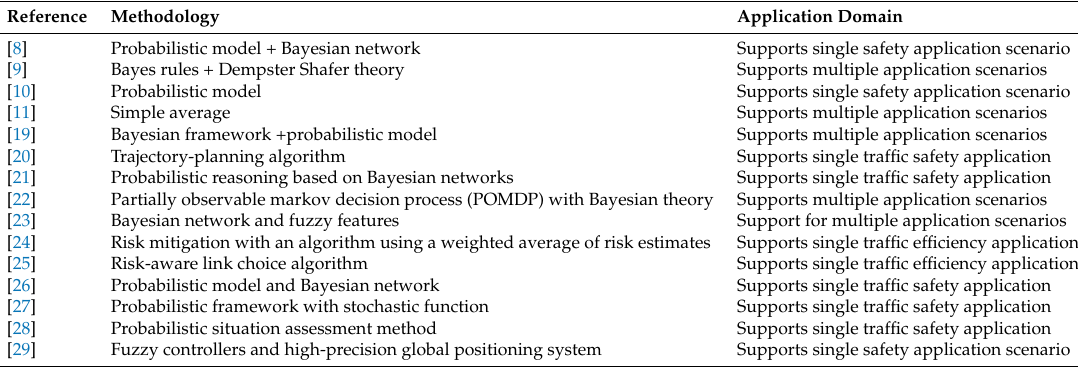
Table 13. Summary of related work.